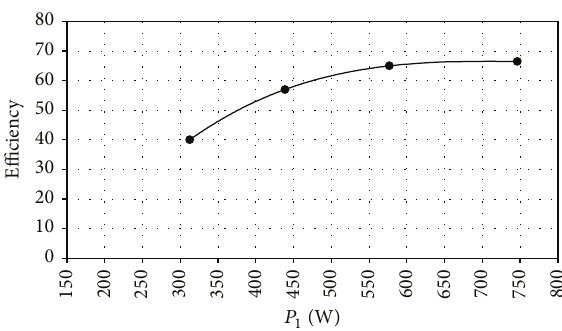
Figure 4: Performance curve of electromotor (efficiency versus power